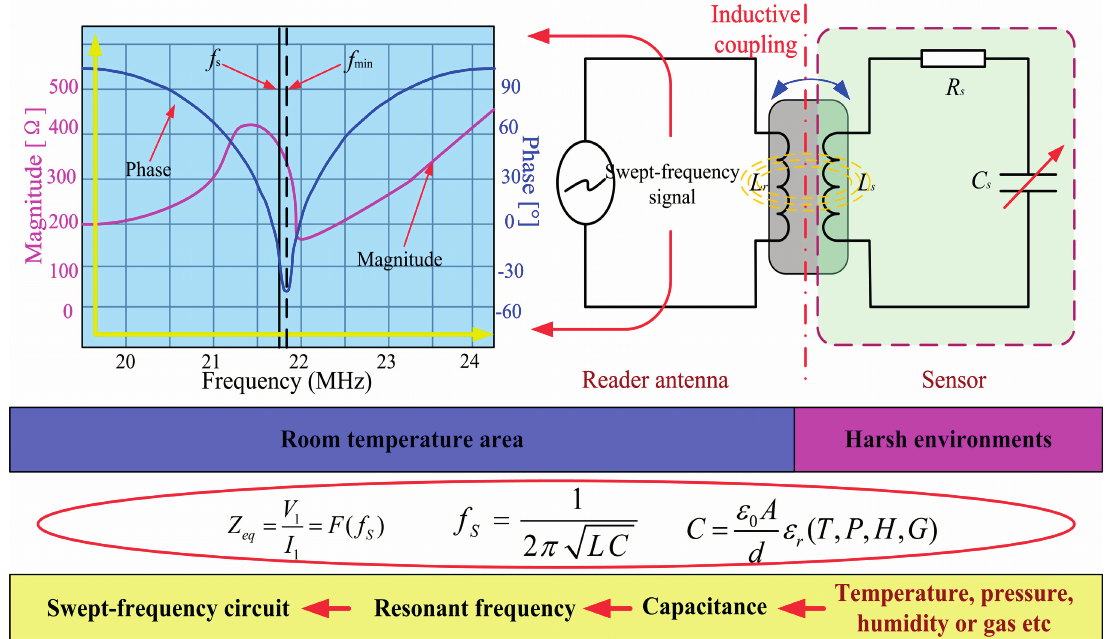
Figure 2. Principles and equations for wireless sensor